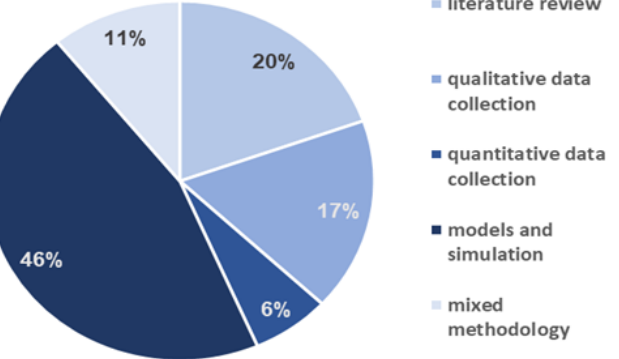
Figure 5. Frequency of different data collection and analysis approaches (source: own elaboration).